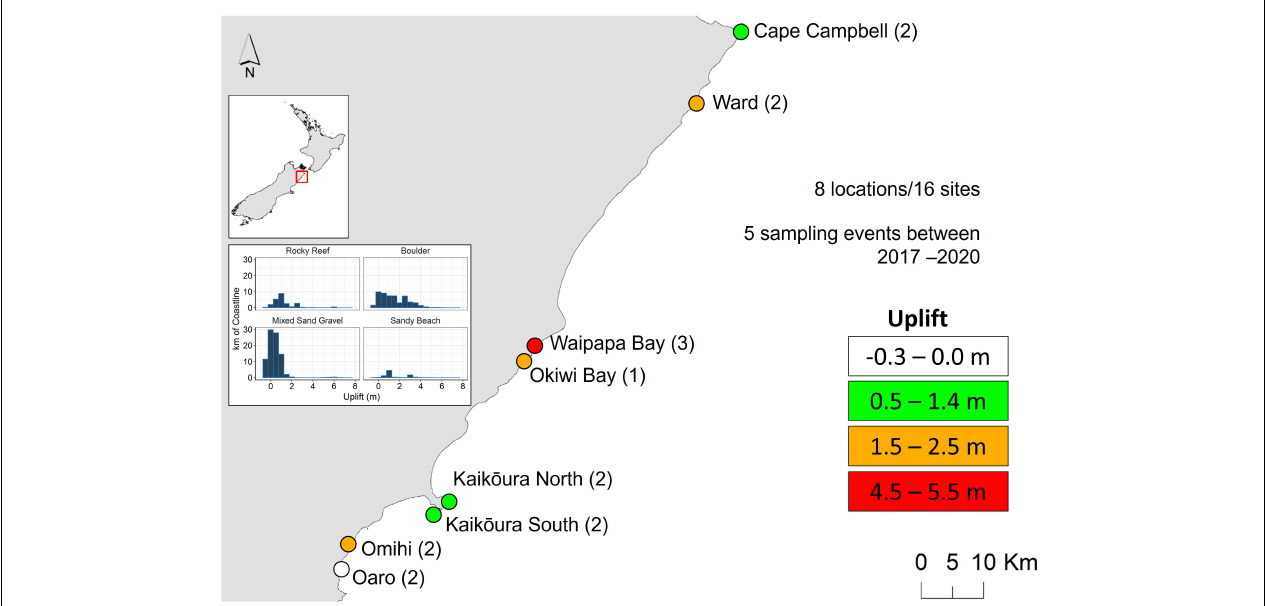
FIGURE 1 | The sites used for repeated monitoring were within 8 “locations,” across c.130 km of coastline. The numbers in brackets indicate the number of sites per location. Uplift categories are indicated. Inset shows the km of coastline within different substratum categories (from Orchard et al., 2021). Sampling was done only in “rocky reef” and “boulder”